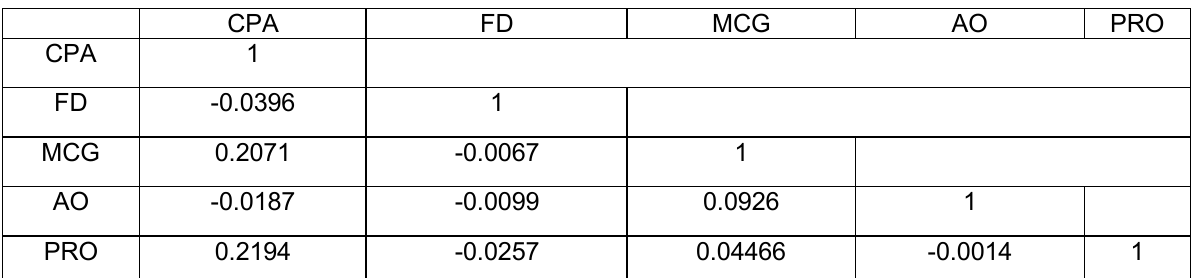
Table 3. Correlation Among Variables